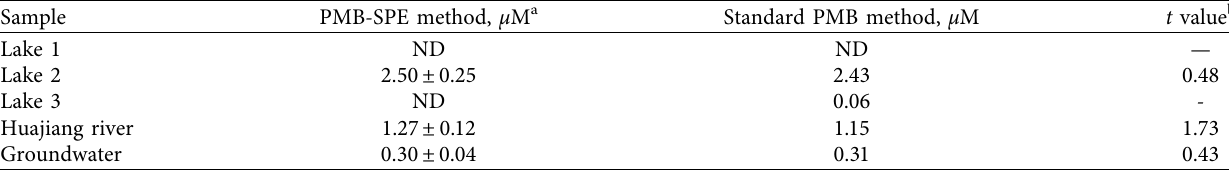
Table 2: Determination of water samples with the proposed PMB-SPE method and a standard PMB